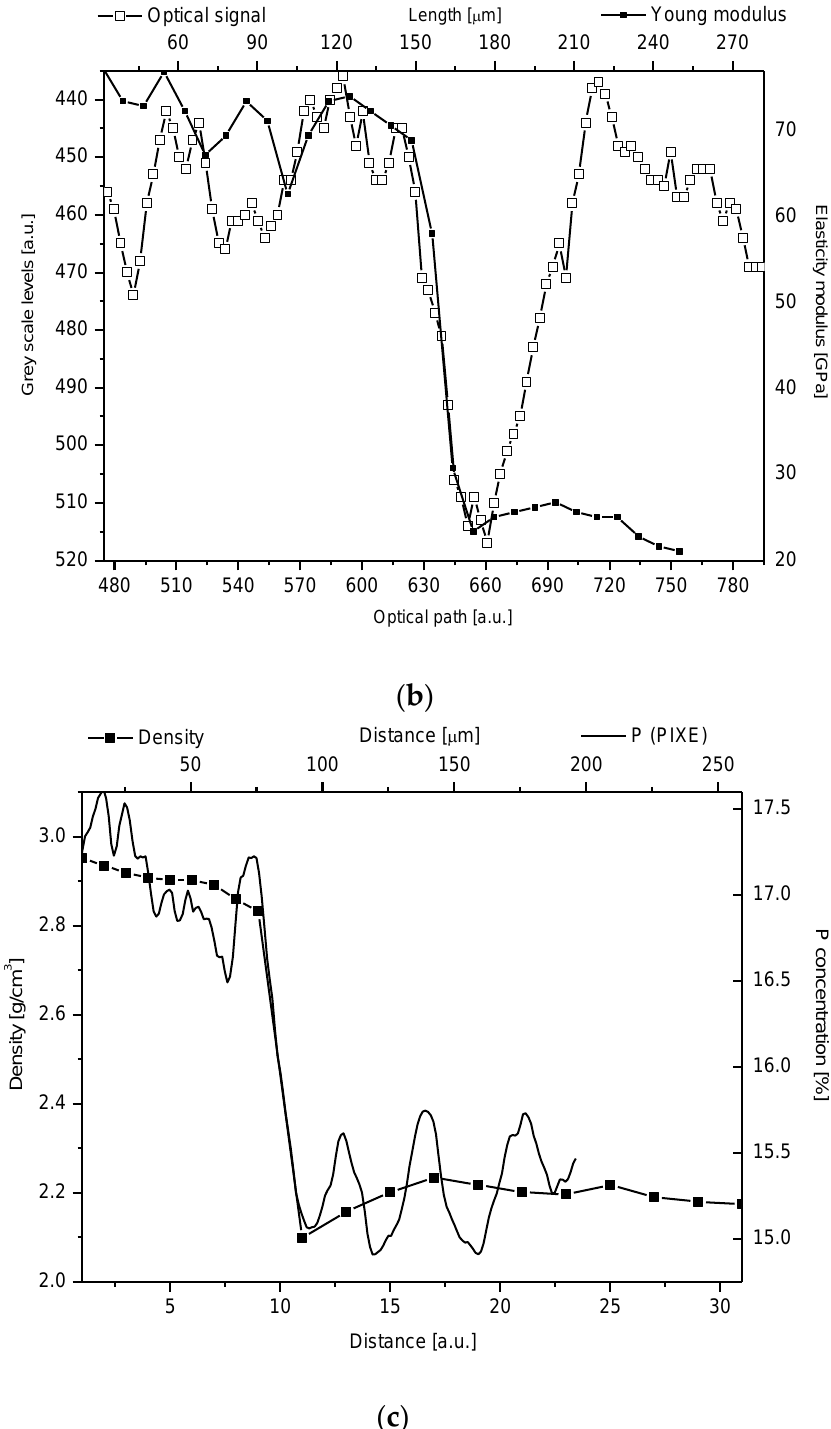
Figure 4. ( a ) Parallel delimitation of the DEJ zone with the EPMA measurements and micromechanical results. The micro-hardness and micro-friction results are adopted from Marshall et al. [12]. The horizontal dashed line delimits the width of the DEJ. ( b ) Superposition of Young modulus on the optical outline of DEJ. ( c ) Superposition of changes in density from Weatherell [35] on P measurement from PIXE.